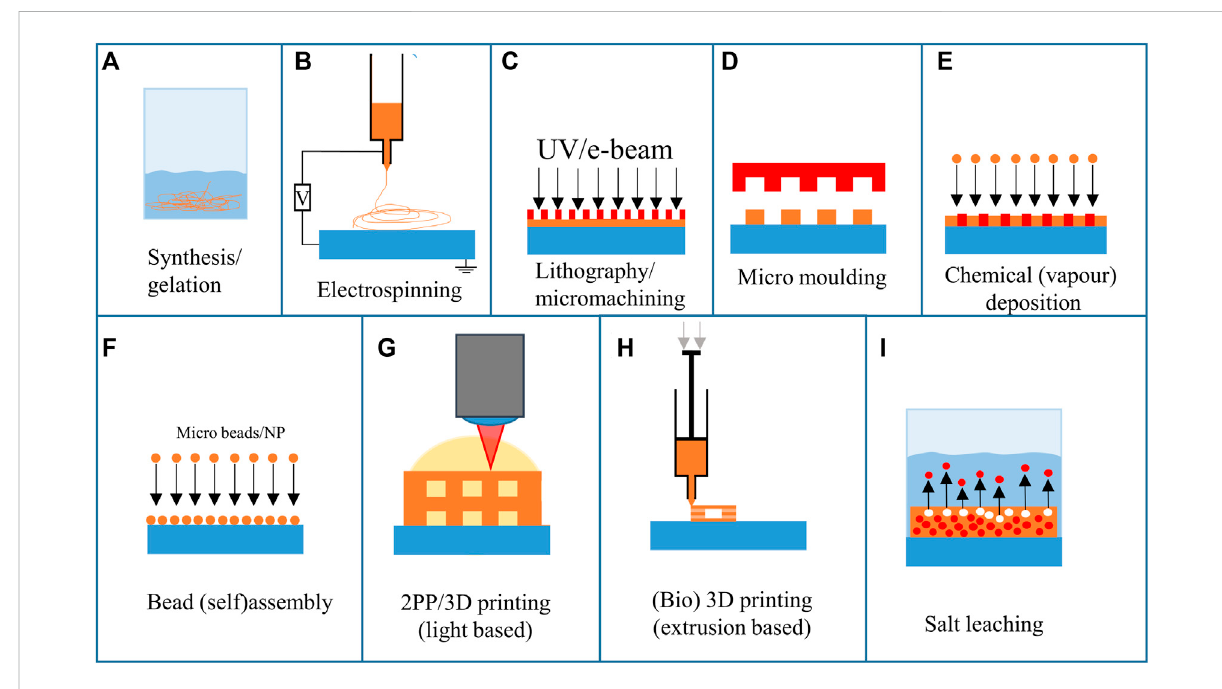
FIGURE 3 Overview of fabrication techniques employed for the realization of neural